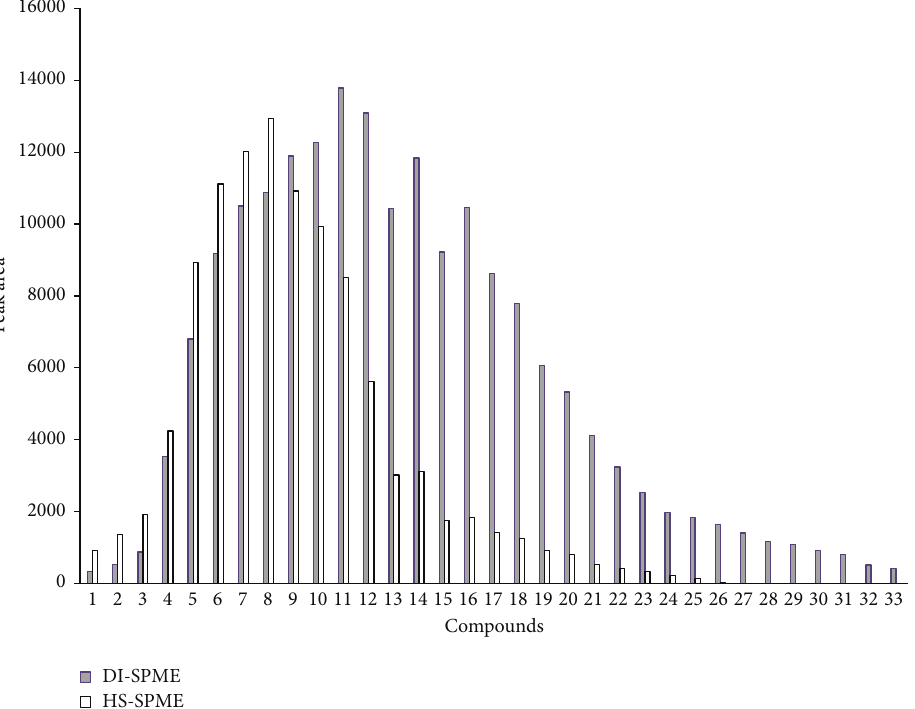
Figure 2: The extraction capability of the sol-gel coated MWNTs-TSO-OH fiber in DI-SPME mode and HS-SPME mode with the C 8 – C 40 standard solution. Peaks: 1, n-octane; 2, n-nonane; 3, n-decane; 4, n-undecane; 5, n-dodecane; 6, n-tridecane; 7, n-tetradecane; 8, n- pentadecane; 9, n-hexadecane; 10, n-heptadecane; 11, n-octadecane; 12, n-nonadecane; 13, n-eicosane; 14, n-heneicosane; 15, n-docosane; 16, n-tricosane; 17, n-tetracosane; 18, n-pentacosane; 19, n-hexacosane; 20, n-heptacosane; 21, n-octacosane; 22, n-nonacosane; 23, n-triacontane; 24, n-hentriacontane; 25, n-dotriacontane; 26, n-tritriacontane; 27, n-tetratriacontane; 28, n-pentatriacontane; 29, n-hexatriacontane; 30, n- heptatriacontane; 31, n-octatriacontane; 32, n-nonatriacontane; and 33,